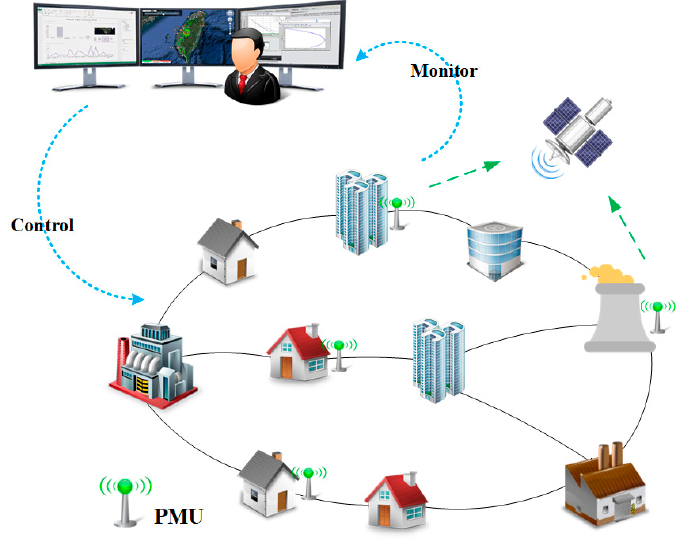
Figure 1. Illustration of phasor measurement unit (PMU)–based wide-area monitoring system (WAMS) in a smart grid.